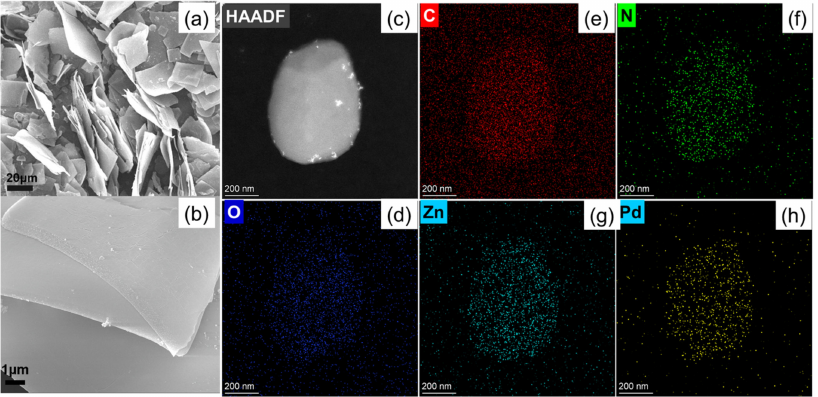
Figure 2. ( a ) SEM, HAADF-TEM ( b ) and TEM-EDS ( c–h ) mapping images of the prepared Zn– TCPP(Pd) MOF